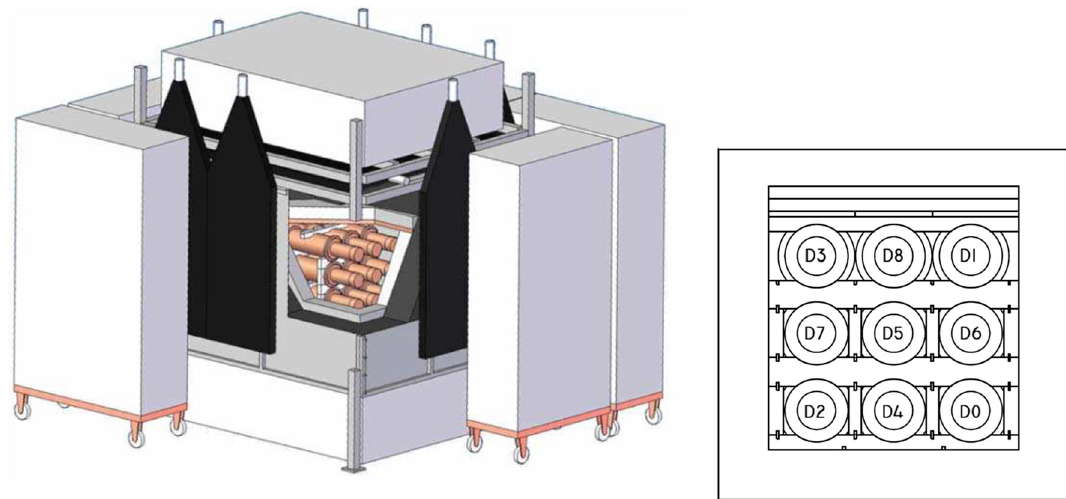
Fig. 1 Design of the whole ANAIS-112 set-up at LSC (left) and detec- tor positions in the 3 × 3 modules matrix (right); detectors are hold in place by a light Teflon structure. The nine detectors are encapsulated in OFE copper and shielded by 10 cm of archaeological lead, 20 cm of